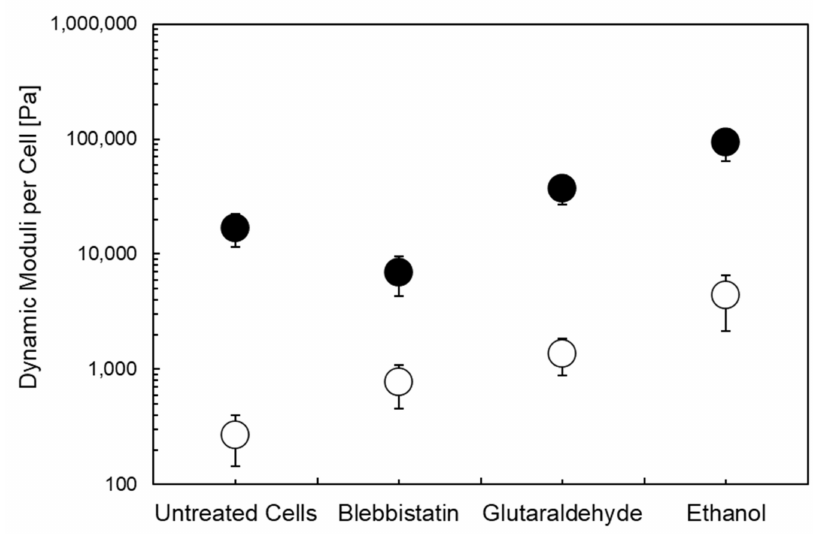
Figure 3. Dynamic moduli per cell for untreated fibroblasts and fibroblasts treated with different drugs [91]. Storage and loss moduli are indicated by close and open symbols, respectively. Frequency: 1 Hz; Gap width: 5 µ